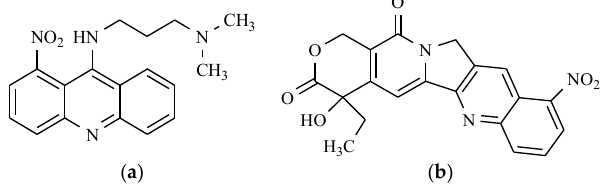
Figure 8. Anticancer drugs: ( a ) Nitracrine; and ( b ) Rubitecan.